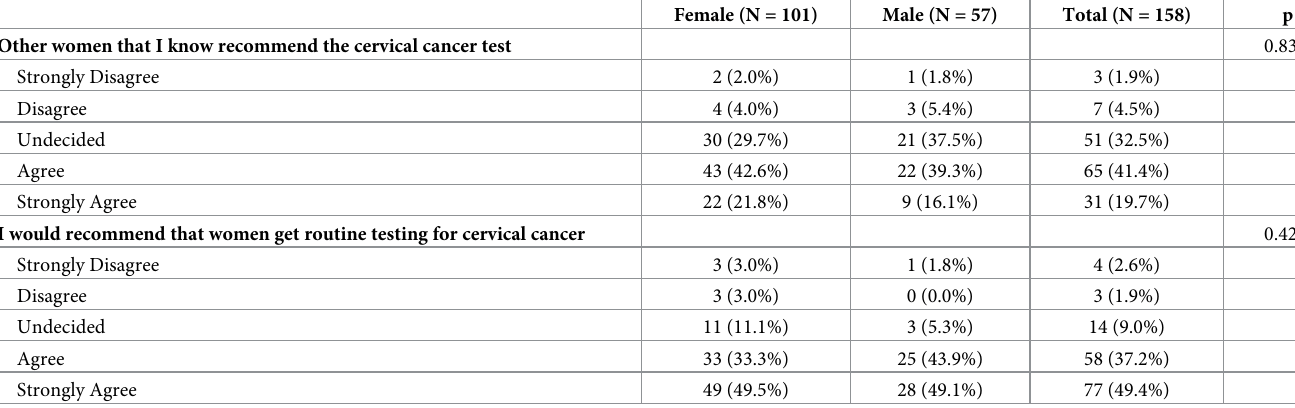
Table 6. Cervical cancer screening recommendation by